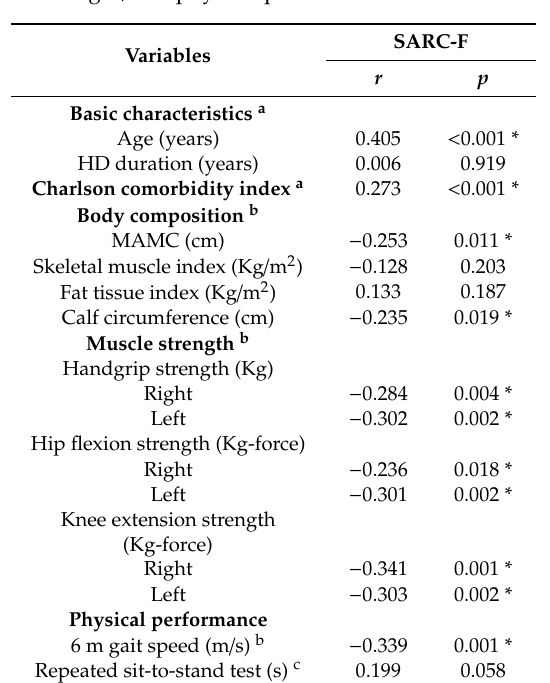
Table 2. Spearman correlation of total SARC-F with basic characteristics, Charlson comorbidity index, body composition, muscle strength, and physical